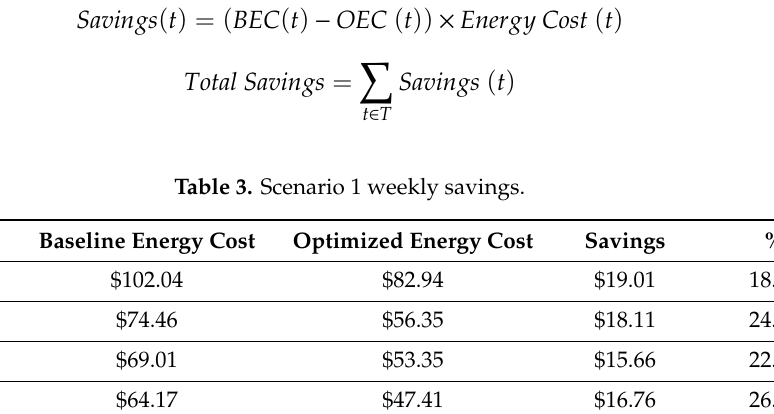
Table 3. Scenario 1 weekly savings.